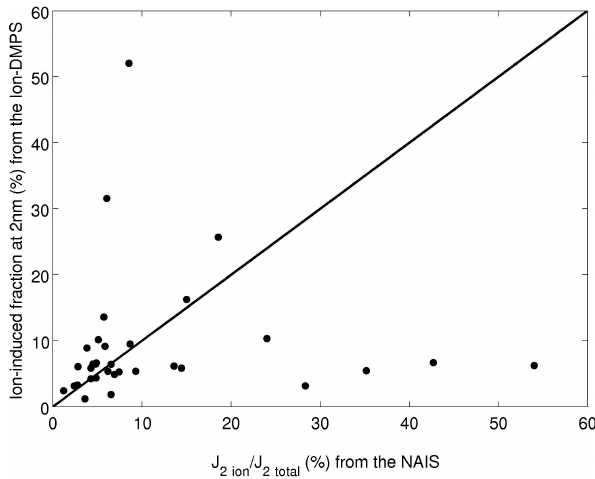
Fig. 2a. Fraction of ion-induced nucleation as a function of the time after sunrise. The median ion-induced nucleation fraction is calcu- lated using the formation rate of 2nm charged particles divided by the total formation rate of 2nm particles from NAIS measurements. The median fraction for 28 overcharged days is shown in red, for 8 undercharged in blue. The horizontal lines represent the median value between 0.2 and 0.35 days after the sunrise (when the event is taking place, on average).